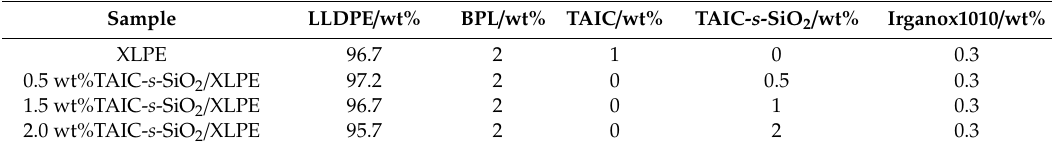
Figure 1. Reaction process of synthesizing crosslinker-functionalized nanosilica. Table 1. Mixture components for preparing UV-XLPE